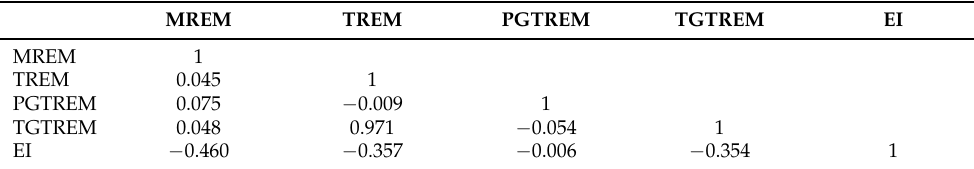
Table 7. Correlation coefficients for the estimated energy efficiency scores and energy